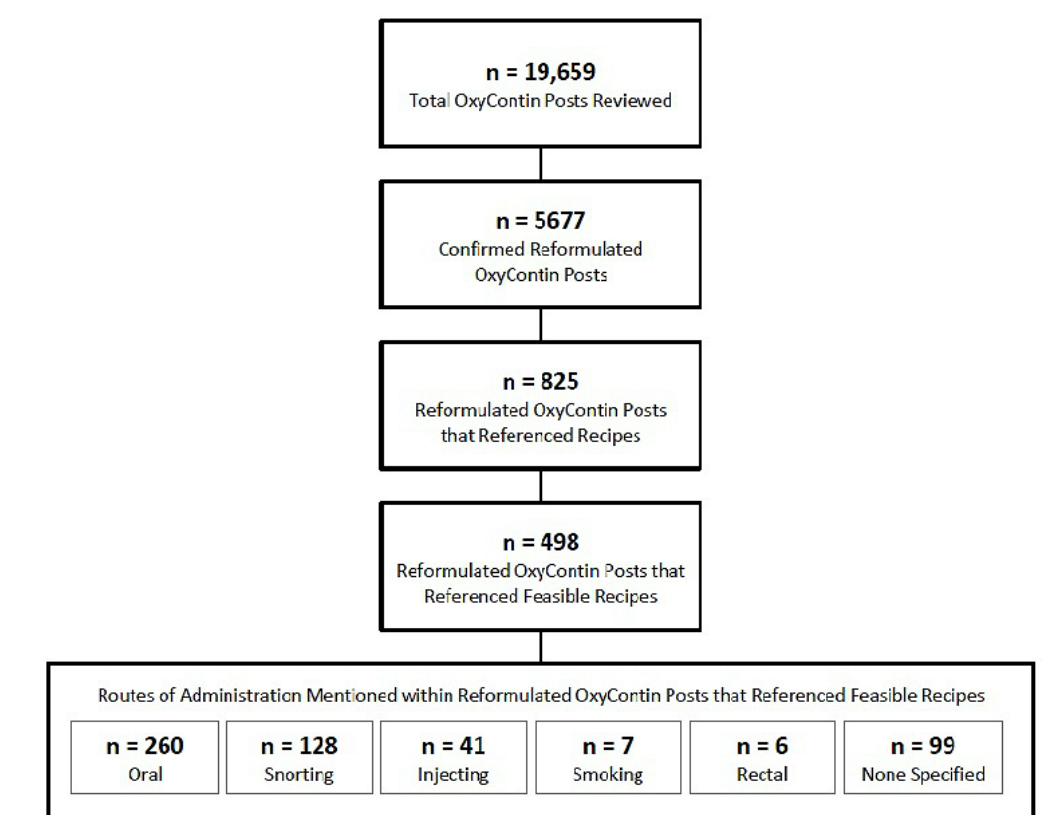
Figure 3. Evaluation of recipes: coding results. Feasibility was defined as being able to manipulate reformulated OxyContin for abuse via an unintended route of administration (ie, use of product other than swallowing the tablet whole).